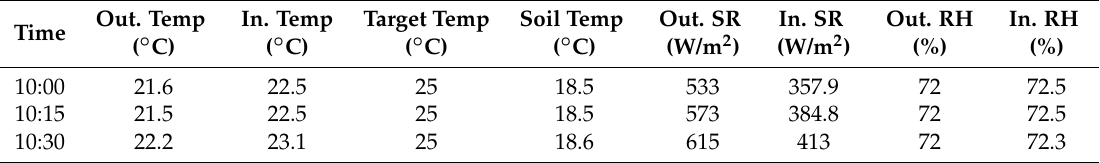
Table 5. Climate characteristics on a day in June (Summer) tomato cultivation in Greenhouse